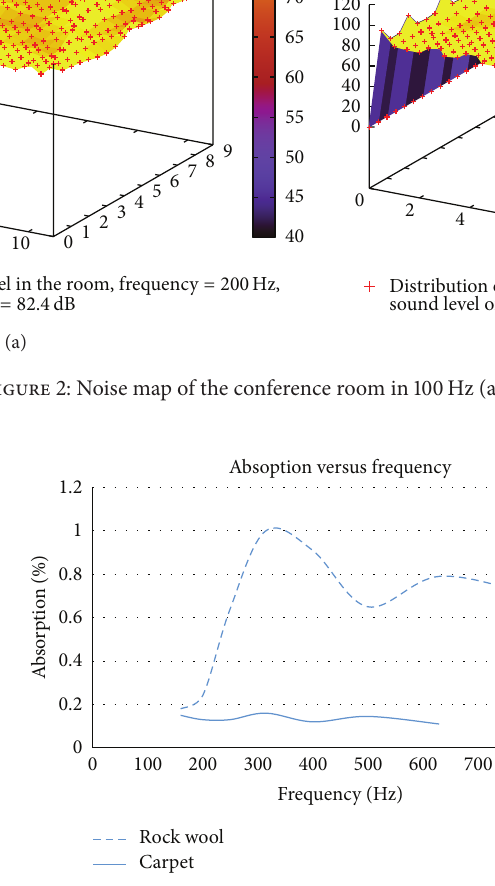
Figure 3: Absorption of rock wool and carpet versus frequency.